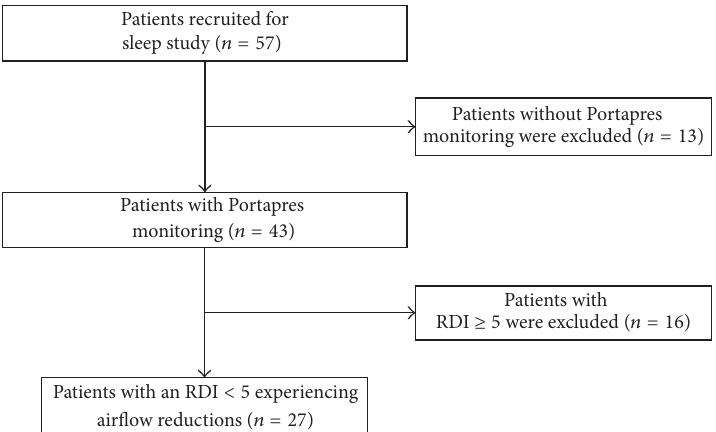
Figure 1: Study population flow chart. Among the 43 patients with Portapres monitoring, 4 patients had no apnea, hypopnea, or RERA (respiratory event related arousal) events, but these patients are included among the 27 patients with an RDI <